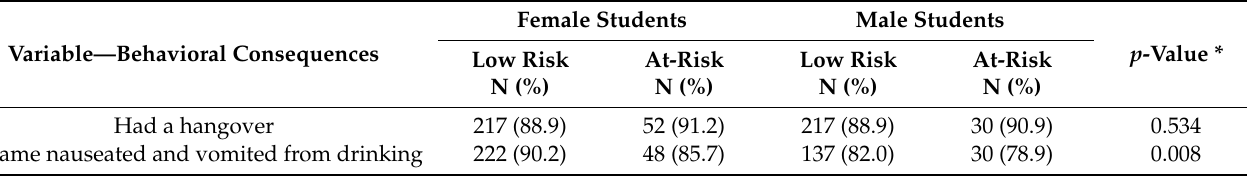
Table 3. Physical problems as a consequence of